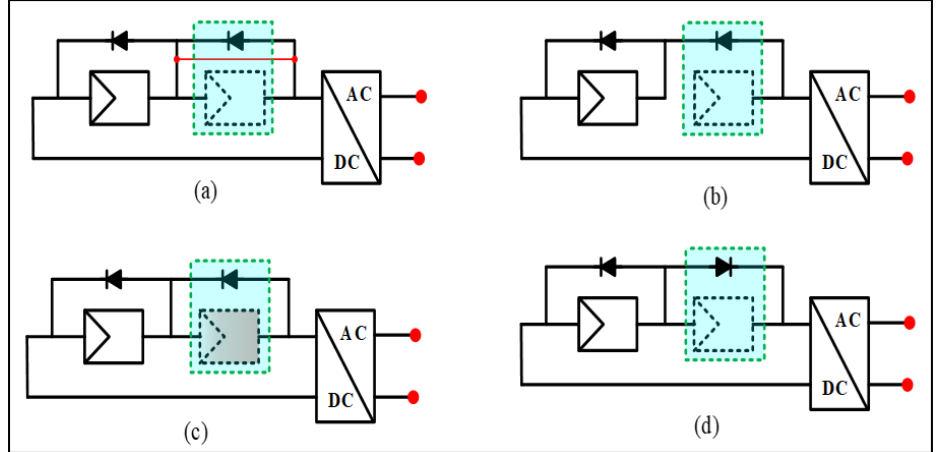
Figure 2. Malfunctioning PV string that included ( a ) short-circuit of one PV module, ( b ) open-circuit of one PV module, ( c ) partial shading of one PV module, and ( d ) bypass diode open-circuiting of one PV module.